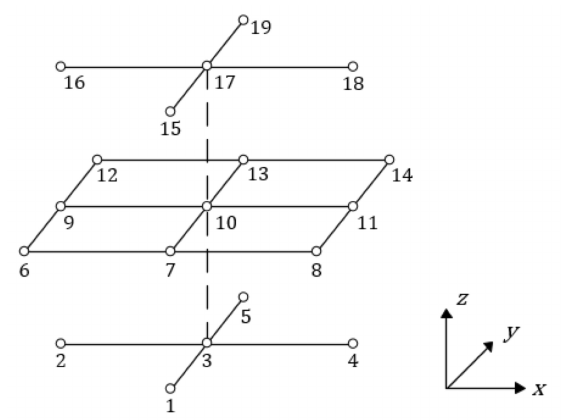
Figure 2. Lexicograpical ordering of the 19-point stencil. Here, element 10 is the current point of the stencil